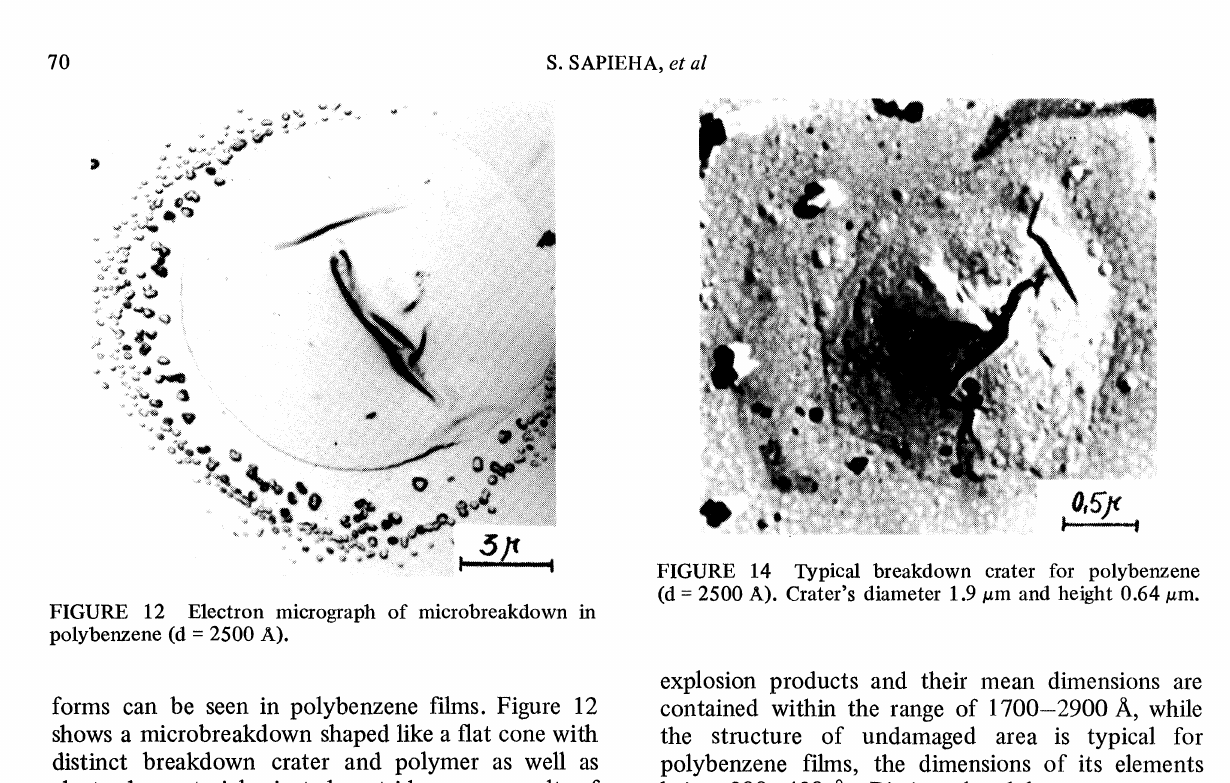
FIGURE 12 Electron micrograph of microbreakdown in polybenzene (d 2500 A).